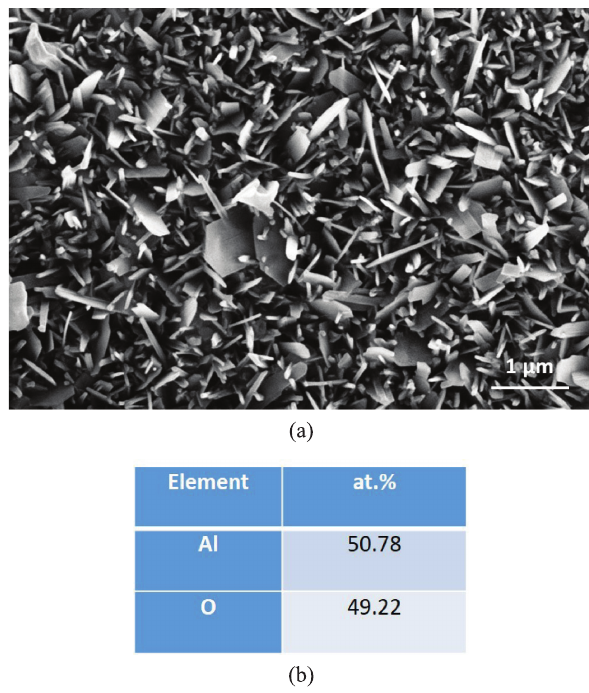
Fig. 5: (a) The surface Ti-46Al-7Nb-0.7Cr-0.1Si-0.1Ni with Al 2 O 3 layer applied after isothermal oxidation in air at 750 °C, (b) chemical composition in the shown